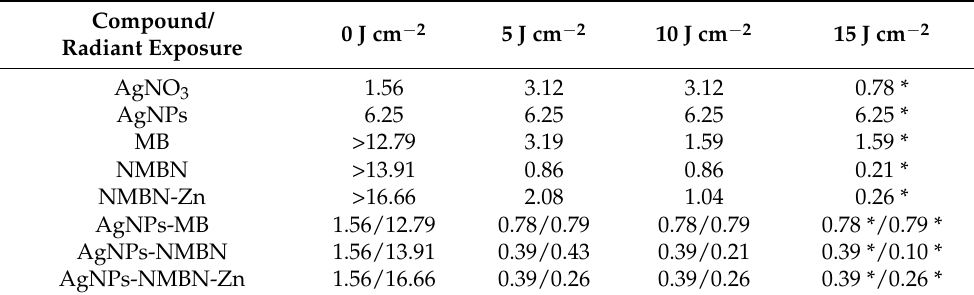
Table 2. Minimum inhibitory concentration (MIC) of AgNPs ( µ g mL − 1 ), phenothiazinium PS (MB, NMBN, and NMBN-Zn in µ g mL − 1 ), and AgNPs-PS in antimicrobial photodynamic treatment (APDT) against F. keratoplasticum . Compound/